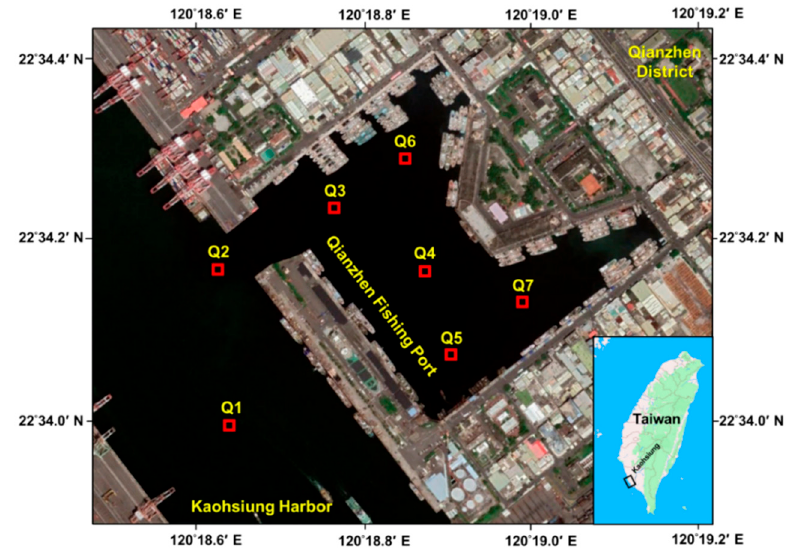
Figure 1. Sampling sites in Qianzhen Fishing Port, Kaohsiung City, southern Taiwan.